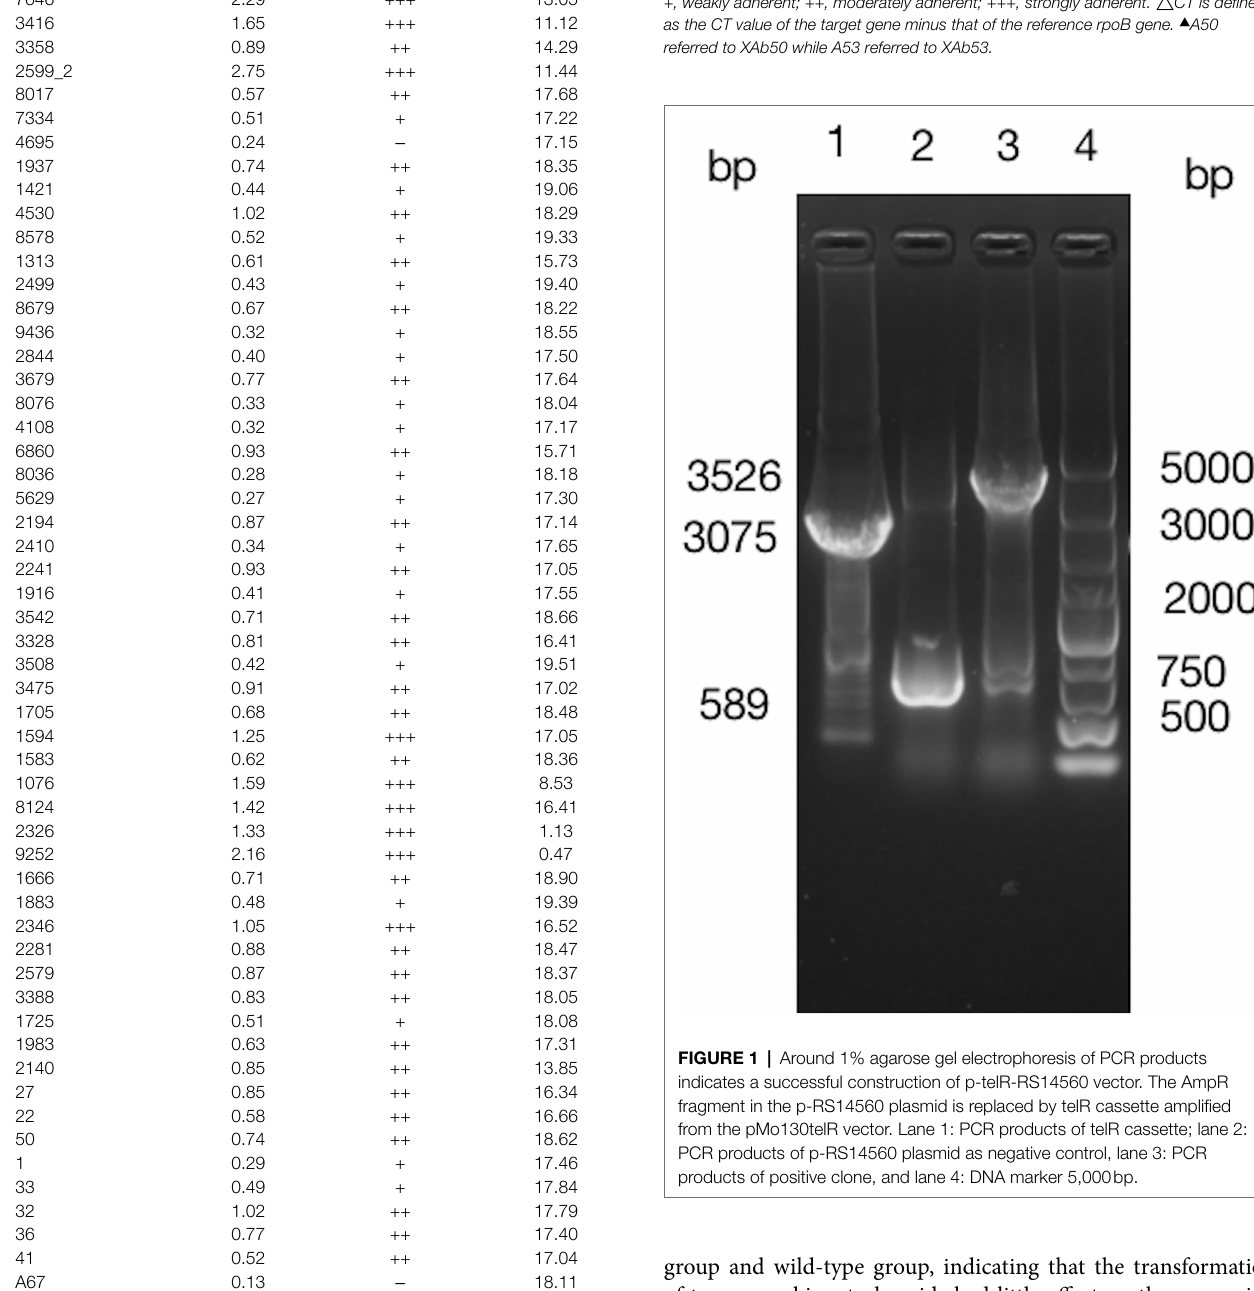
group and wild-type group, indicating that the transformation of two recombinant plasmids had little effect on the expression of BIT33_RS14560 gene ( p > 0.05 ). For ATCC 19606 strain with the plasmid overexpressing the gene of interest, when compared with its control group, the expression level of the BIT33_RS14560 was significantly increased at 311.5 folds ( p < 0.0001 ). For XAb53 strain, the relative expression levels of BIT33_RS14560 in the overexpression group was surprisingly higher at about 586